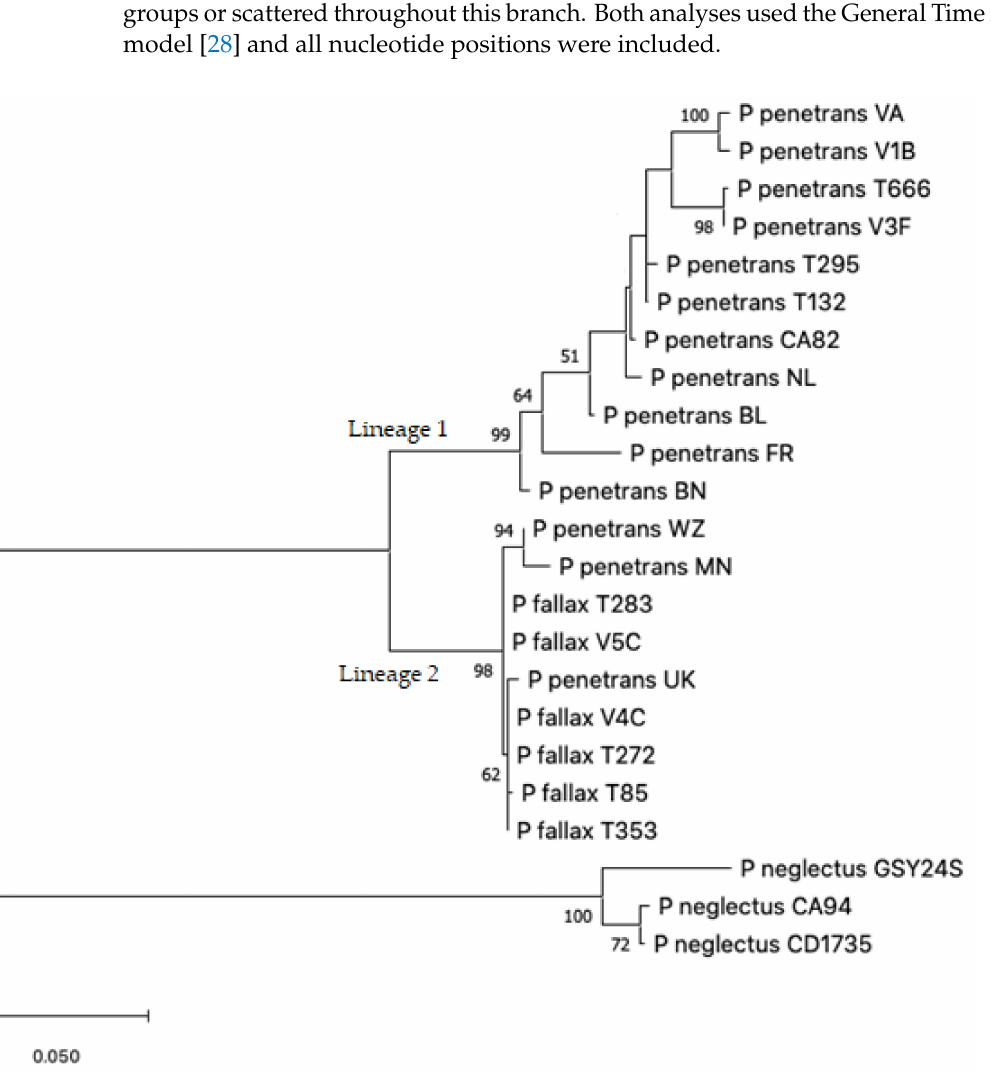
Figure 1. ML tree based on the combined D2-D3 rDNA and COXI dataset. Bootstrap values > 50 are shown. Scale bar indicates number of substitutions per